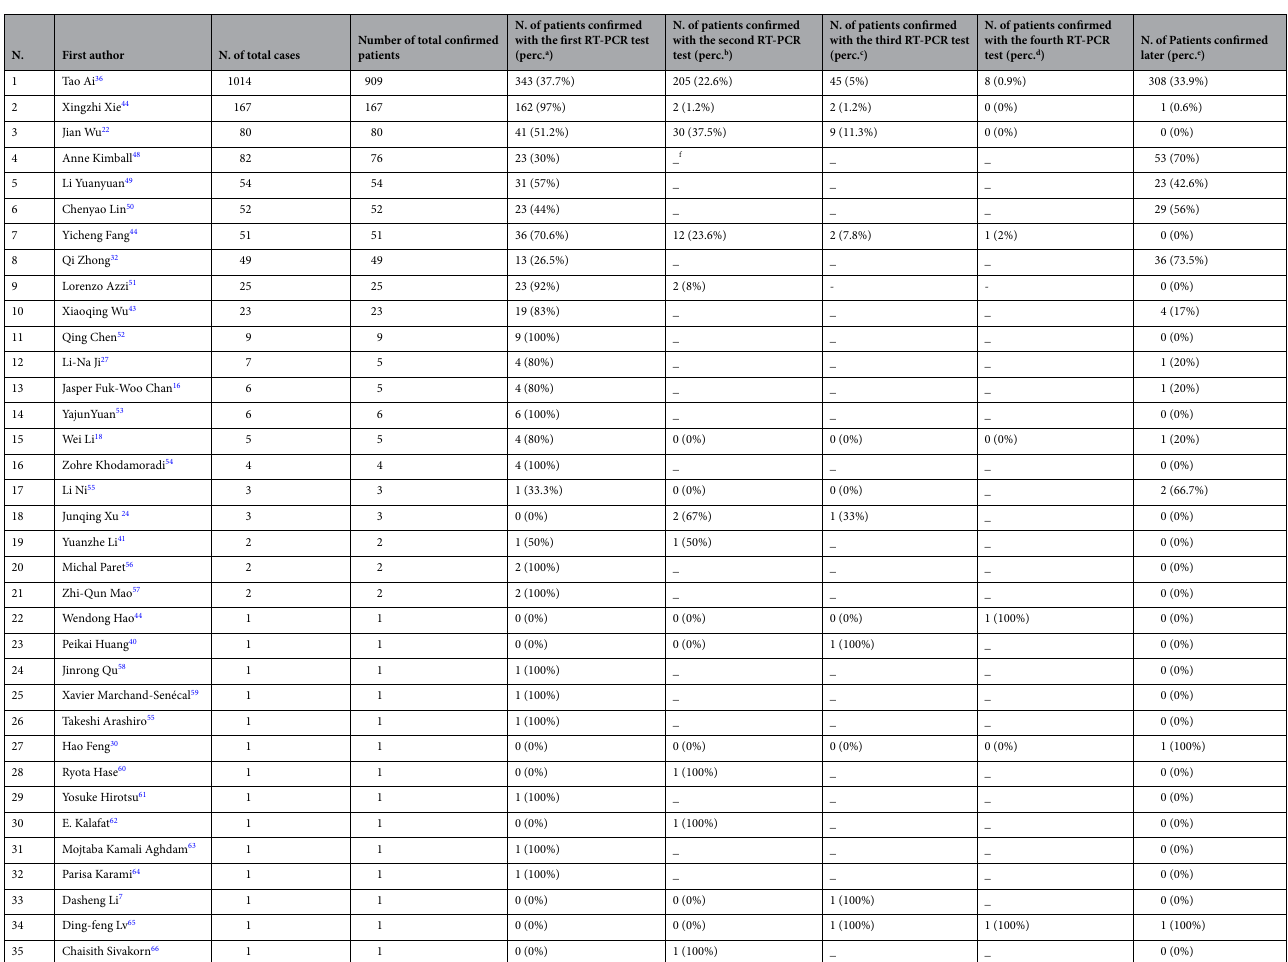
Table 2. The number of positive test results in RT-PCR testing and the number of confirmed ones. a Number of primarily confirmed patients divided total confirmed patients. b Number of secondary confirmed patients divided total confirmed patients. c Number of thirdly confirmed patients divided total confirmed patients. d Number of fourthly confirmed patients divided total confirmed patients. e Number of patients who were confirmed later divided by total confirmed patients. f This means the test has not been conducted or